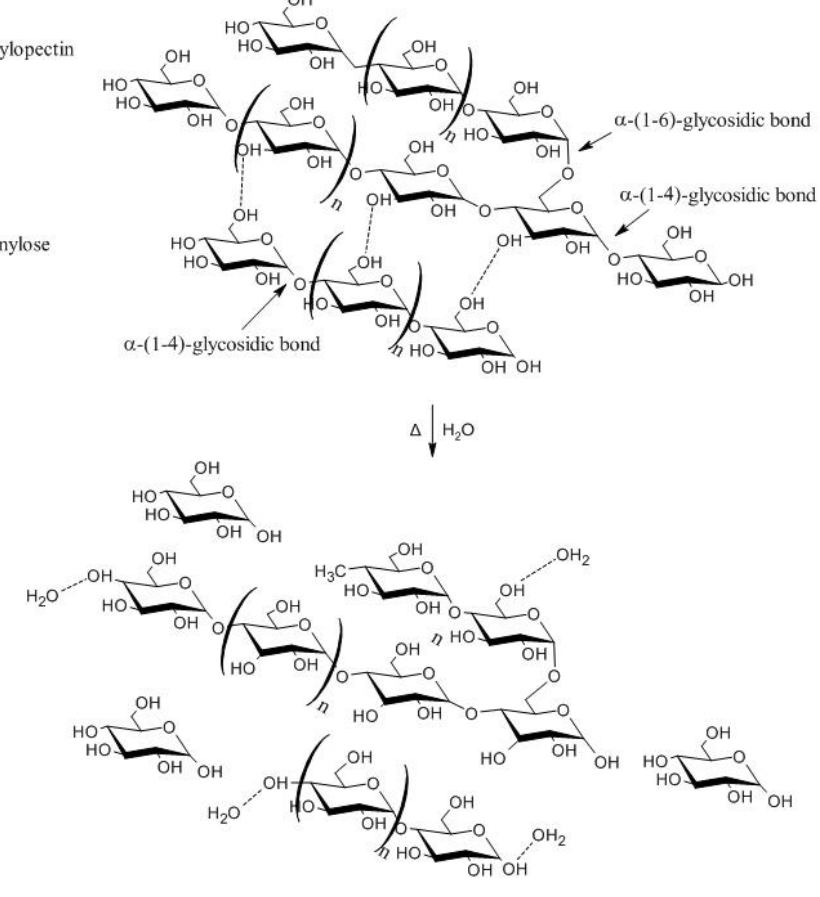
Figure 2. Gelatinization of starch.